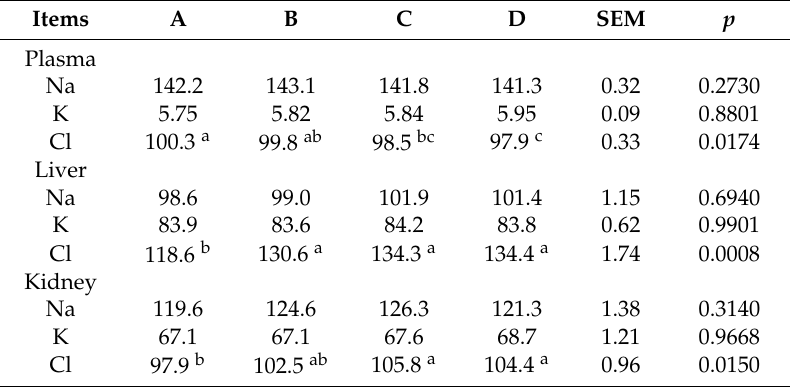
Table 3. Effect of betaine on electrolytes of high-salt stressed Sprague–Dawley rats (mmol/L).